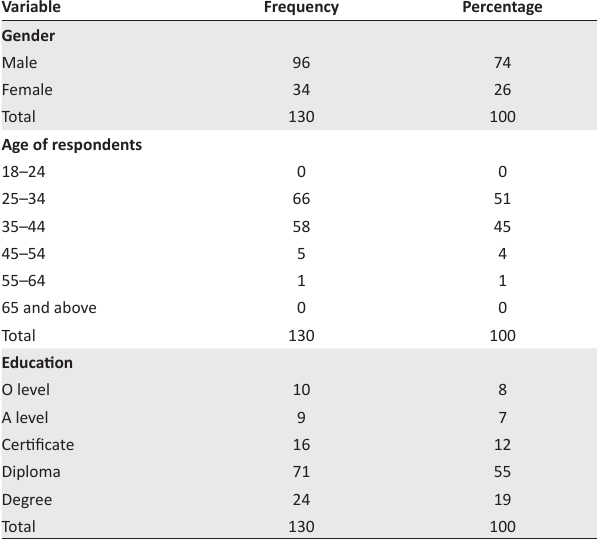
FIGURE 1: Map showing the five ecological regions in